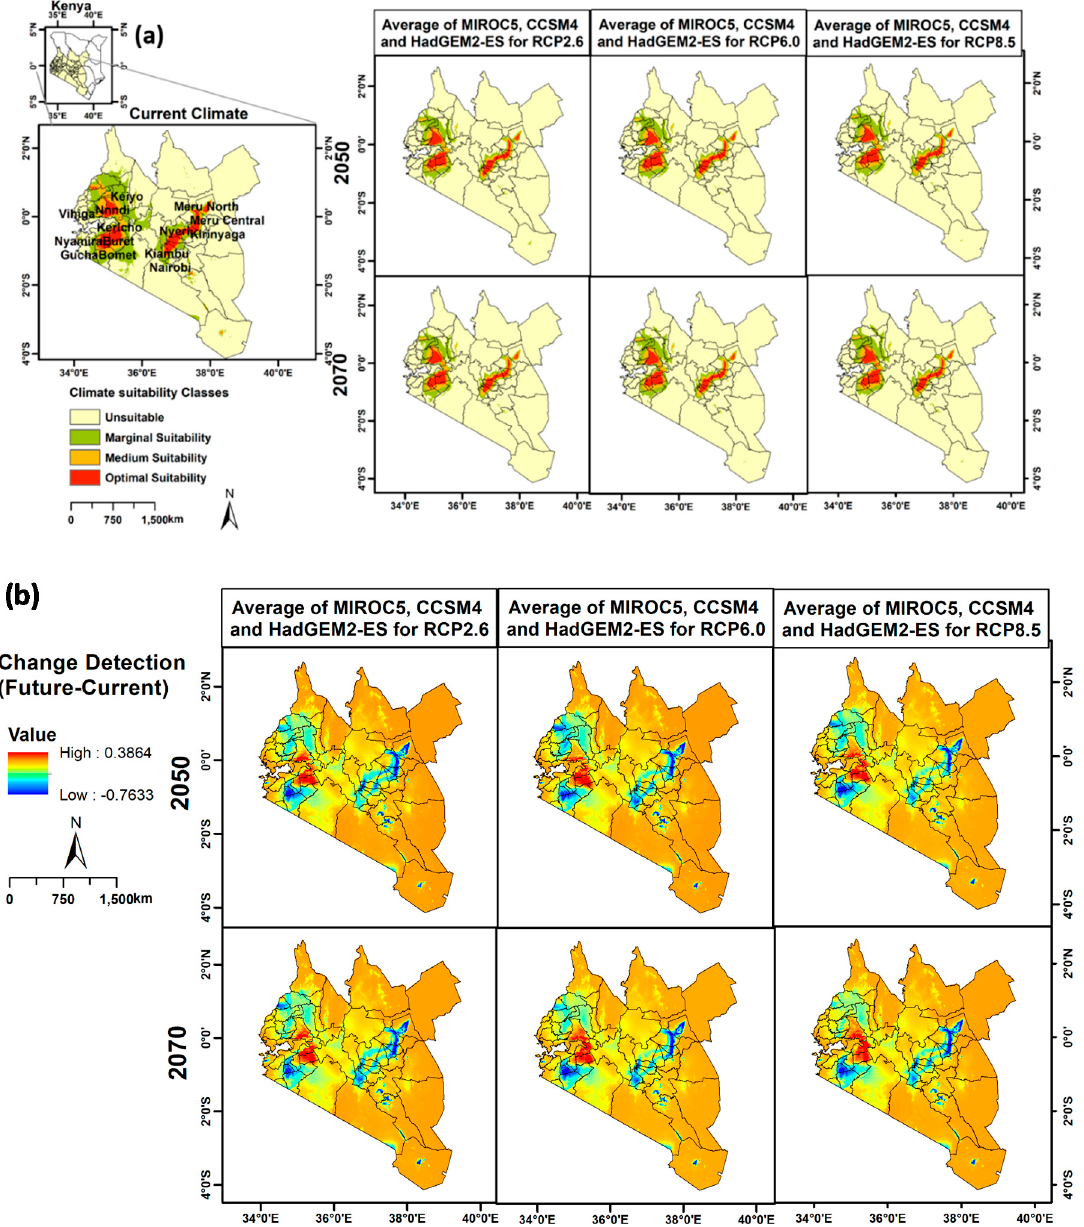
Figure 3. Current and future habitat suitability for Camellia sinensis in Kenya ( a ) and change detection (loss or gain of suitability area) ( b ).